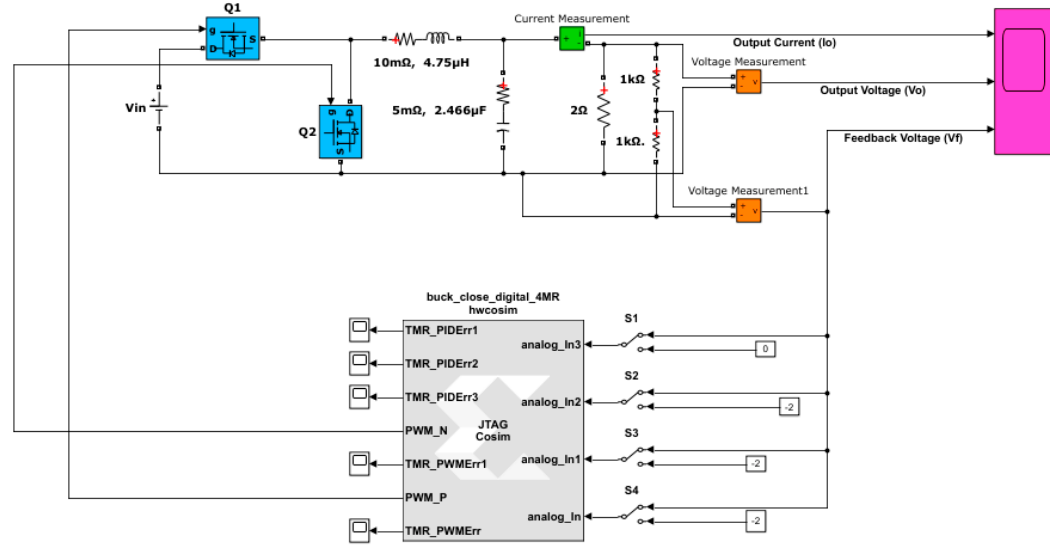
Figure 5. Hardware-in-the-loop (HIL) simulation block including the power stage.